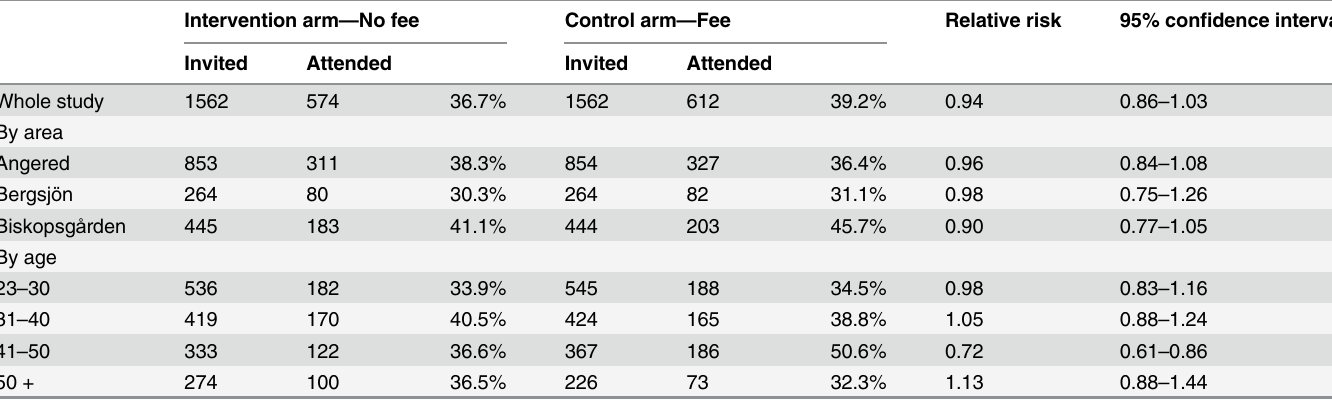
Table 1. Attendance in intervention and control